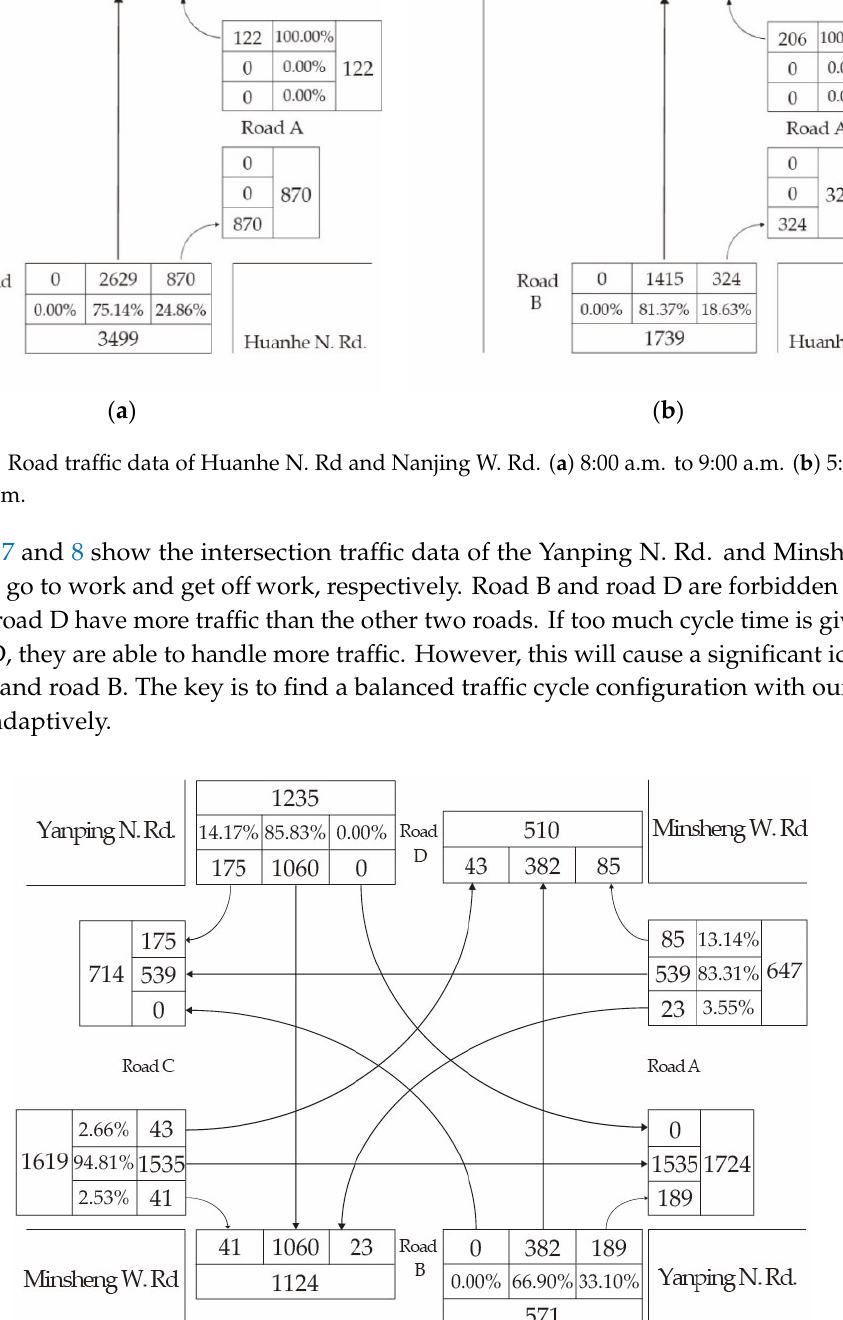
Figure 7. Road traffic data from 8:00 a.m. to 9:00 a.m. on Minsheng W. Rd. and Yanping N. Rd. Figure 7. Road tra ffi c data from 8:00 a.m. to 9:00 a.m. on Minsheng W. Rd. and Yanping N.